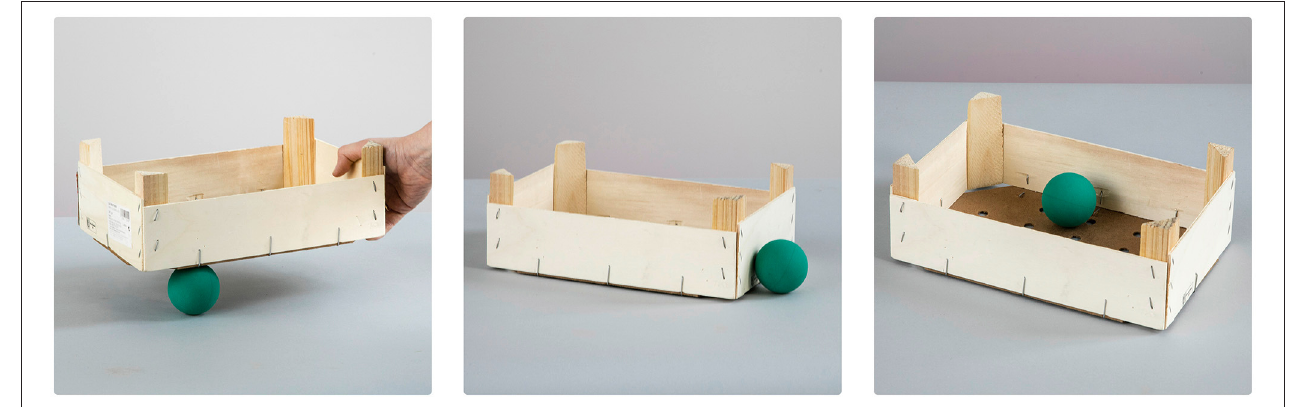
FIGURE 2 | Coding examples for test item put the ball under the box. The first picture is correct, the second and third are incorrect.